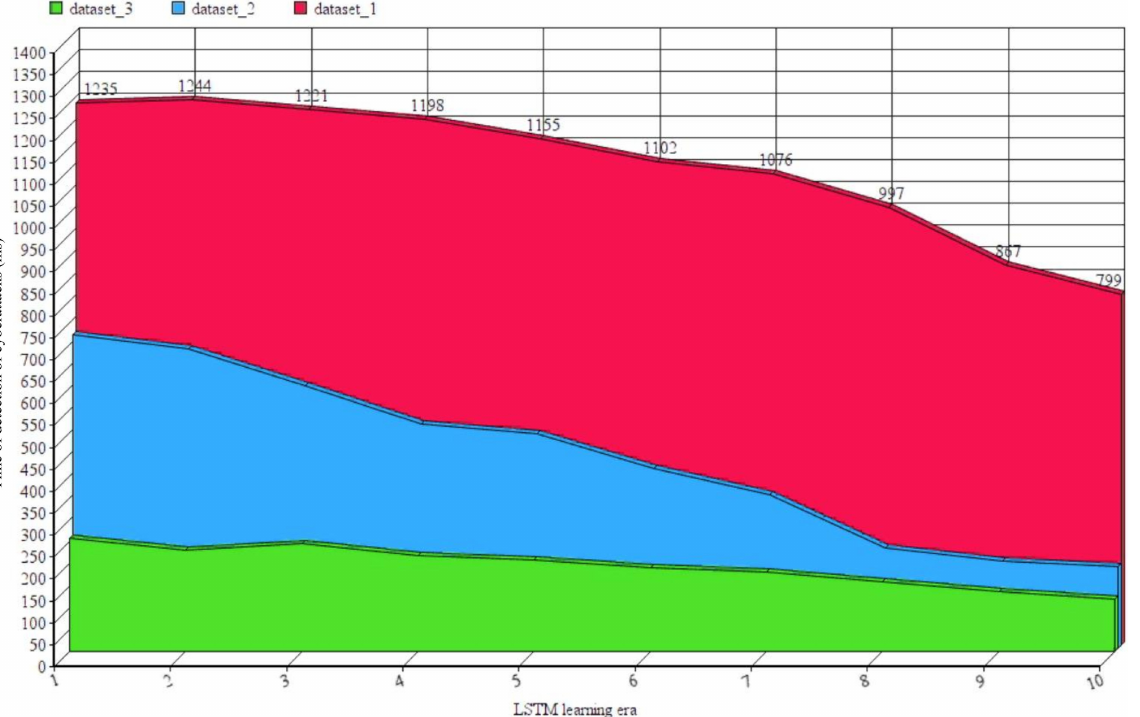
Figure 37. Dependences of the system response time from the volume of the processed data and the learning